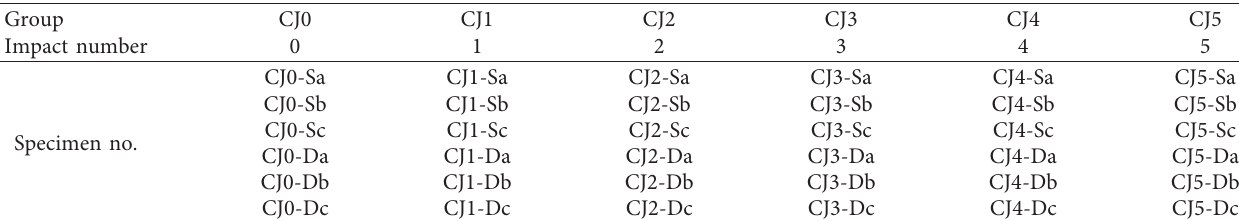
Figure 3: Photograph of cyclic impact loading tests. Table 2: Specimen numbers and test